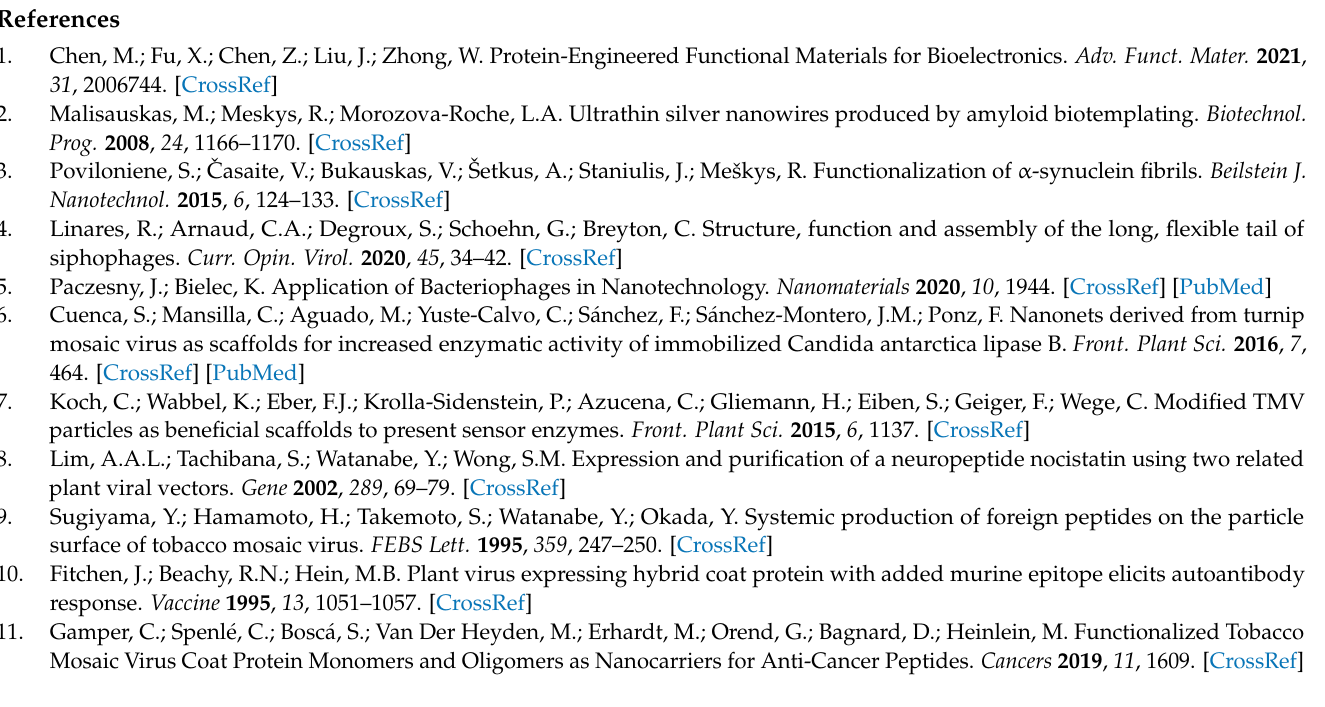
cells. Table S1: Primers used for cloning of truncated 041 gene variants. Figure S2: TEM analysis of nanotubes of recombinant protein 041 and its truncated variants. Figure S3: Schematic figure of constructed chimeric genes. Figure S4: TEM analysis of chimeric nanotubes. Table S2: Analysis of assembly of recombinant chimeric proteins. Figure S5: Thermostability of 041 ∆ 200YqfB and YqfB after 2 and 24 h of